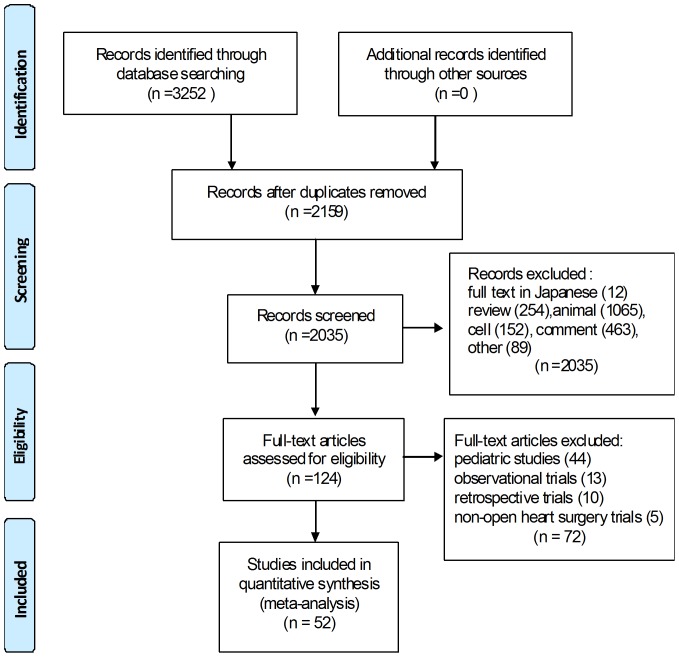
Flow chart showing how eligible studies were identified.